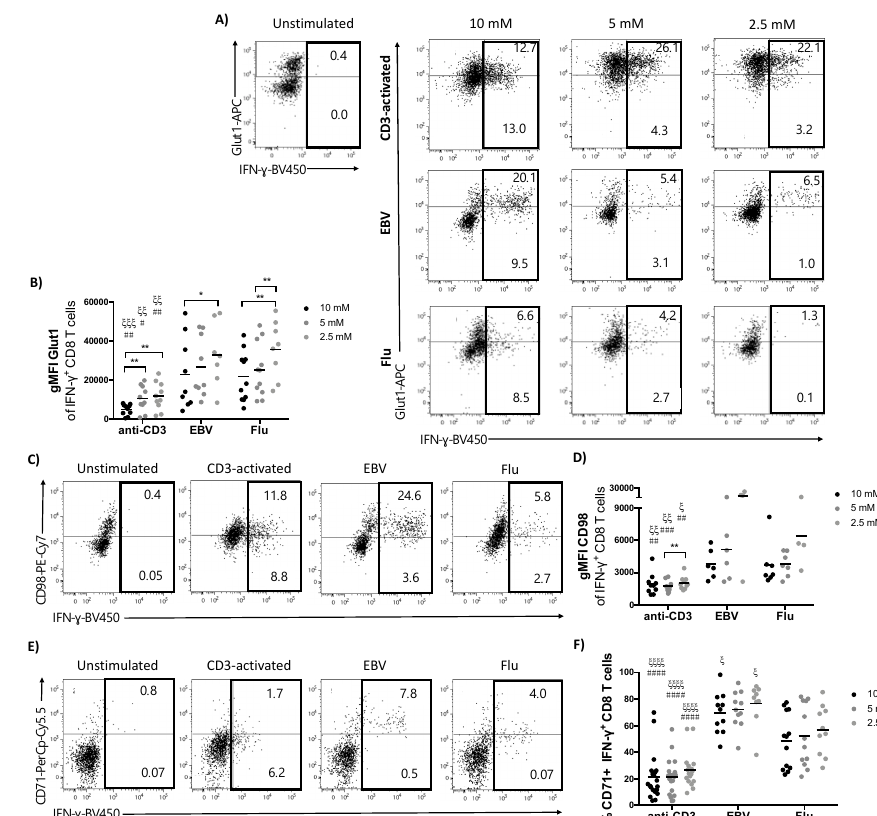
Figure 5. Virus-specific T cells have a highly activated metabolic profile compared to CD3-activated T cells. T cells were stimulated as outlined in Figure 1A. Metabolic markers were assessed upon restimulation on day 7 in the responding IFN- γ + CD8 T cell population. ( A ) Representative dot plots showing Glut1 expression and IFN- γ production by CD8 T cells after stimulation in media containing different concentrations of glucose. ( B ) gMFI of Glut1 in the IFN- γ + CD8 T cell population. ( C ) Representative dot plots showing CD98 expression and IFN- γ production by CD3-activated or virus-specific CD8 T cells after stimulation in media containing 10 mM of glucose and ( D ) summary data showing gMFI of CD98 in IFN- γ + CD8 T cells at all glucose concentrations. ( E ) Representative dot plot of CD71 expression in 10 mM glucose and ( F ) percentage of CD71 + IFN- γ + CD8 T cells in different concentrations of glucose. Mann–Whitney test when comparing between the same concentration of glucose in different groups, ξ p < 0.05, ξξ p < 0.01, ξξξ p < 0.001, ξξξξ p < 0.0001 when comparing with flu-stimulated group and # p < 0.05 ## p < 0.01 ### p < 0.001, #### p < 0.0001 when comparing with EBV-stimulated group. Wilcoxon paired t test when comparing between glucose concentrations within the same group, * p < 0.05, ** p < 0.01, *** p <